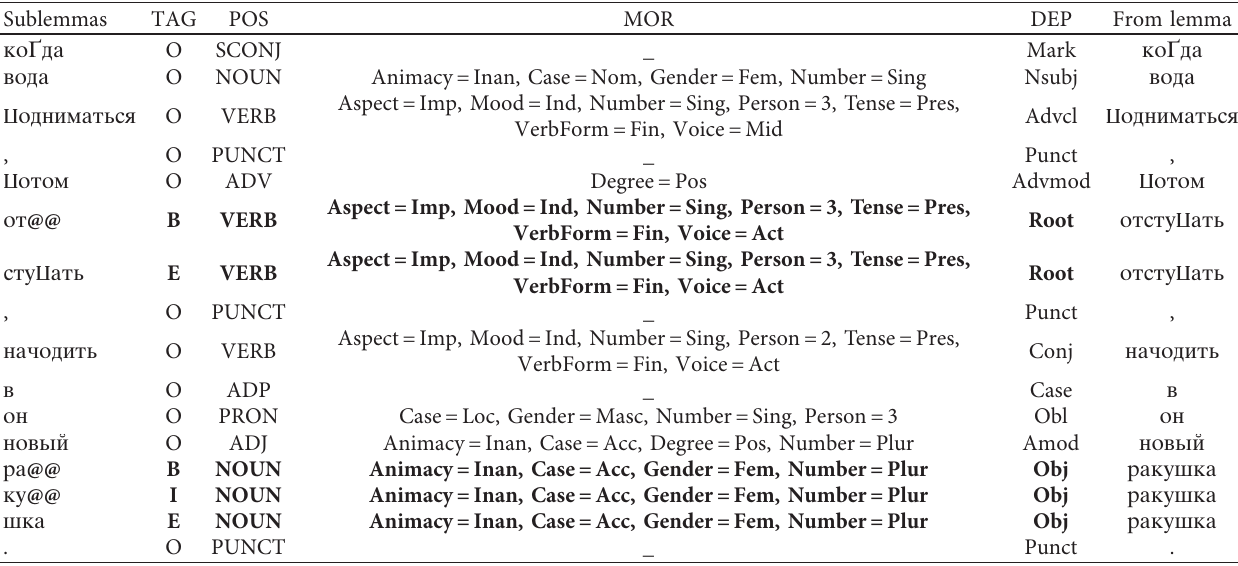
Animacy � Inan, Case � Acc, Degree � Pos, Number � Plur Amod opc9k raluzlj NOUN Animacy � Inan, Case � Acc, Gender � Fem, Number � Plur Obj raluzla . PUNCT _ Punct Table 2: Sublemma-based sequences of linguistic features